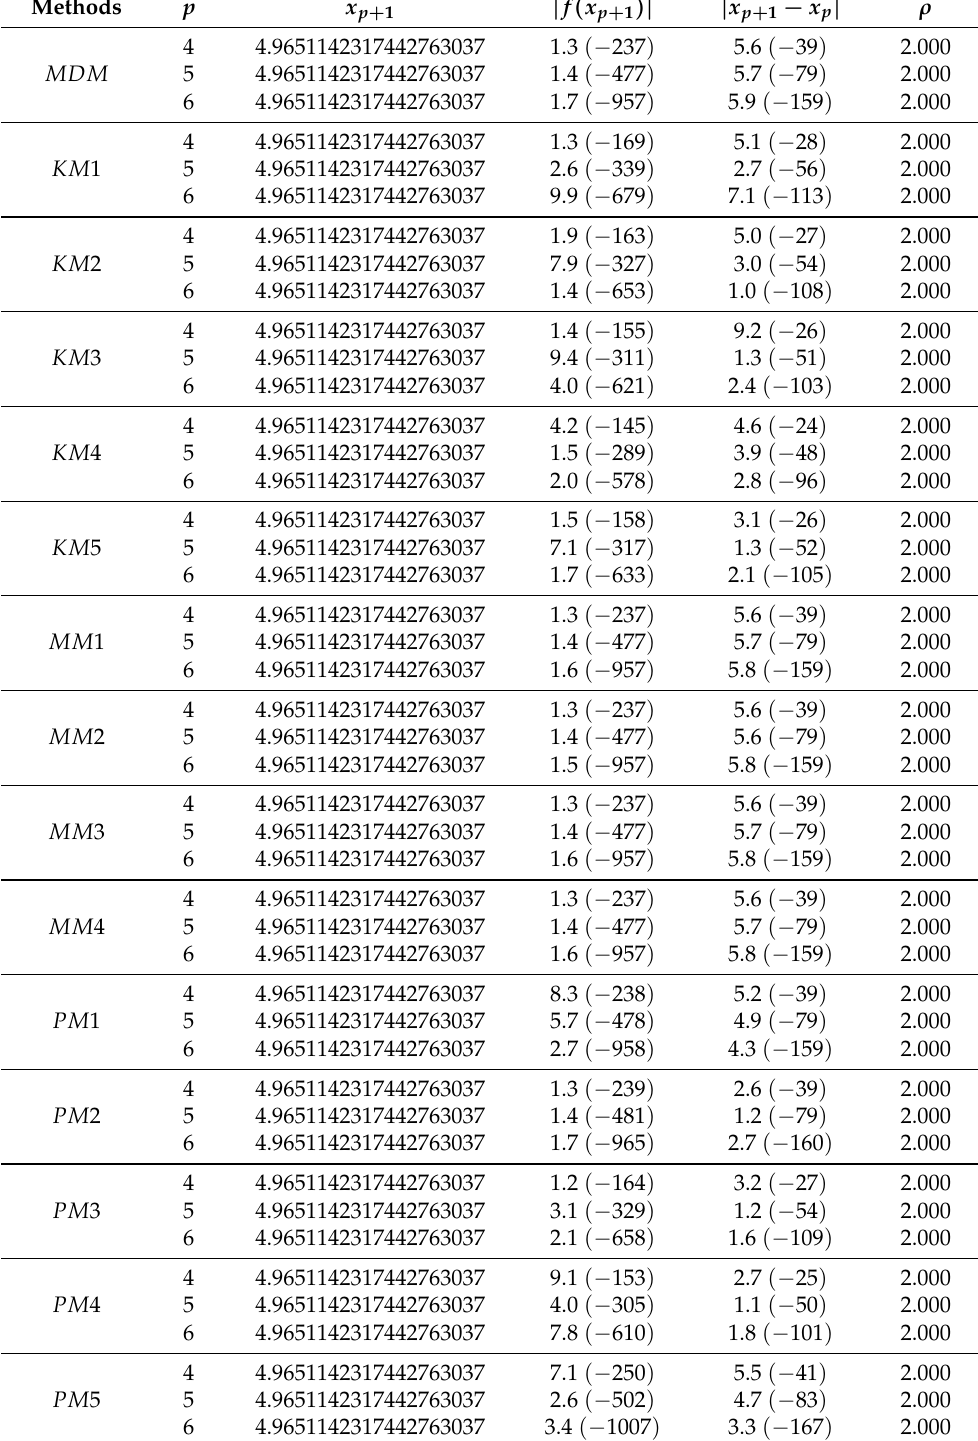
Table 5. Comparison of different iterative methods of Example